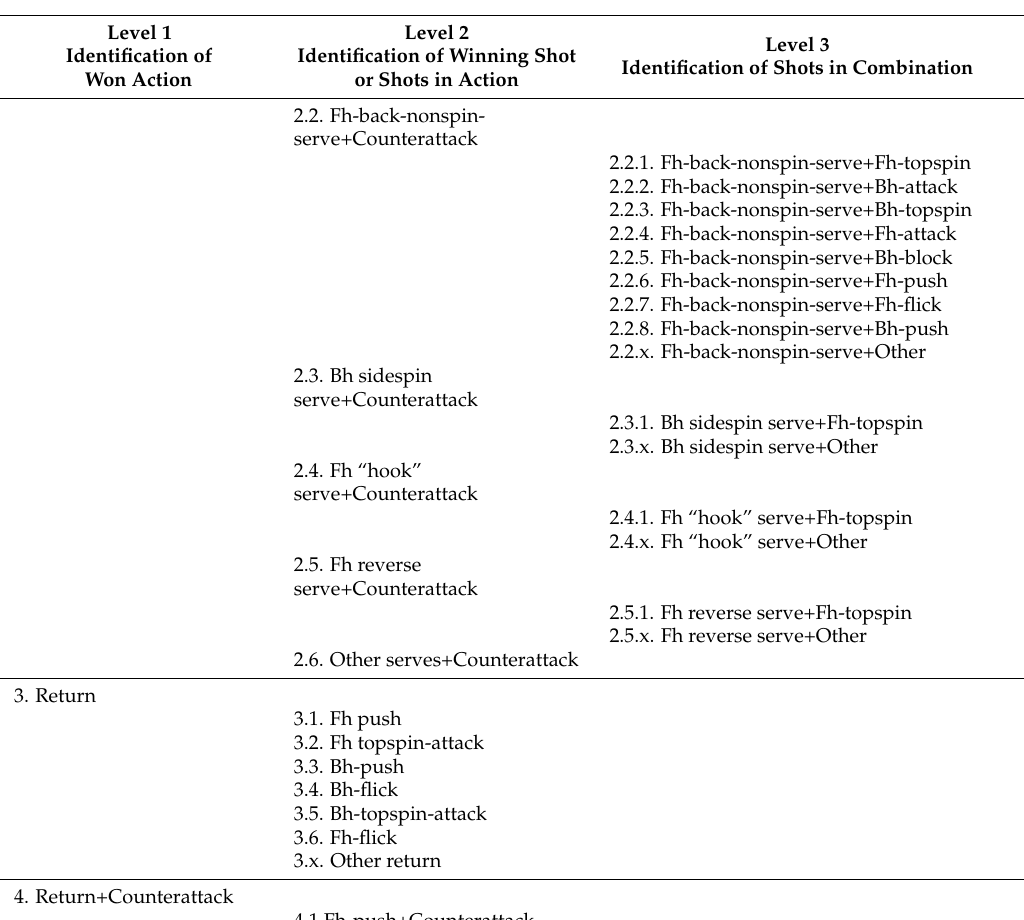
Table 1. Cont. Observational Sheet